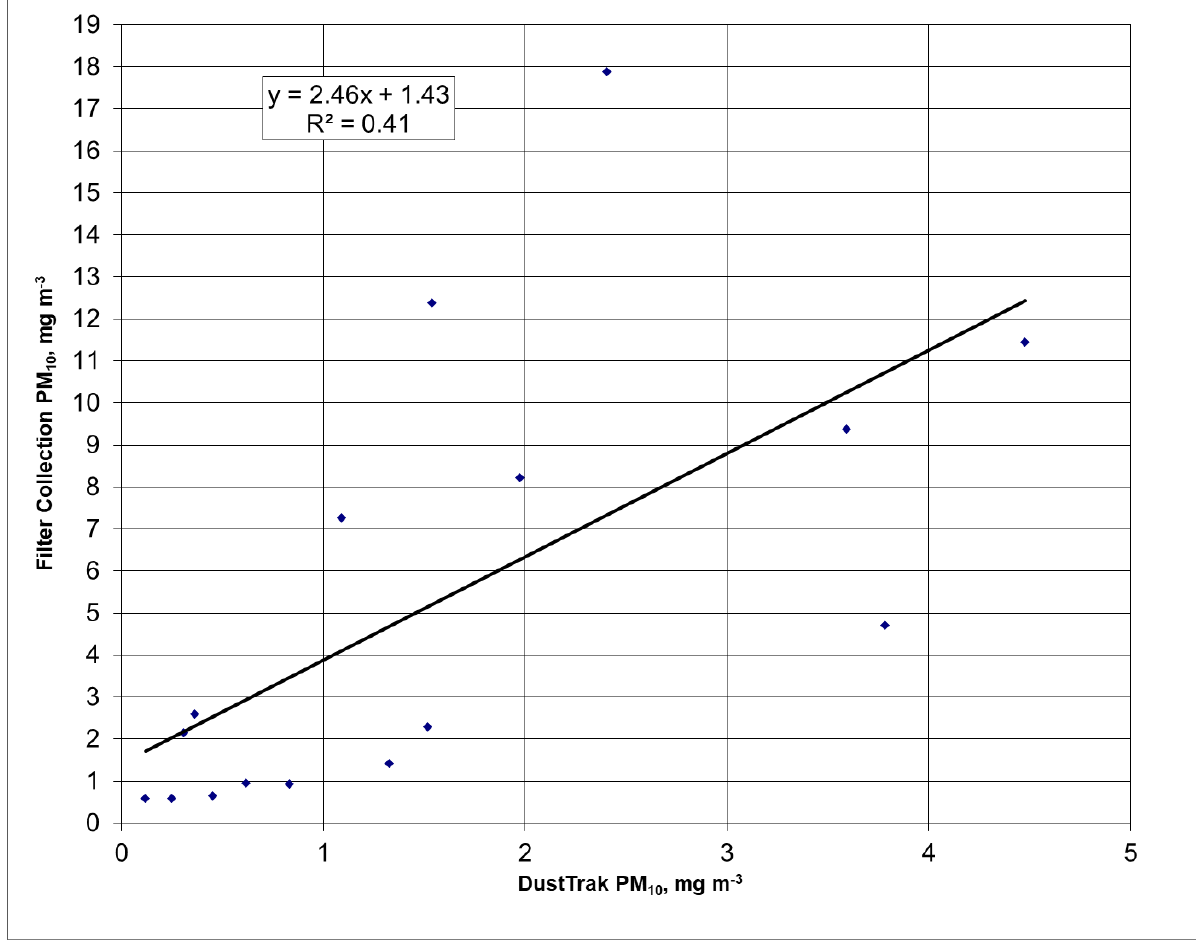
Figure 6. Comparison of PM 10 filter and DustTrak™ data.